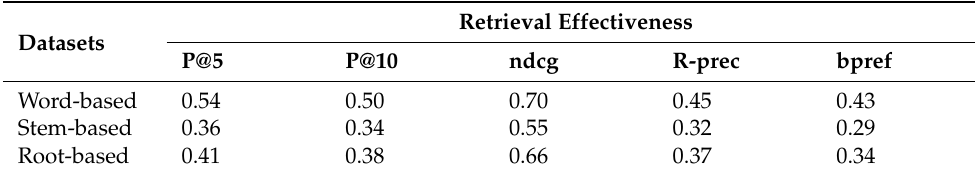
Table 8. Retrieval effectiveness of query expansion using